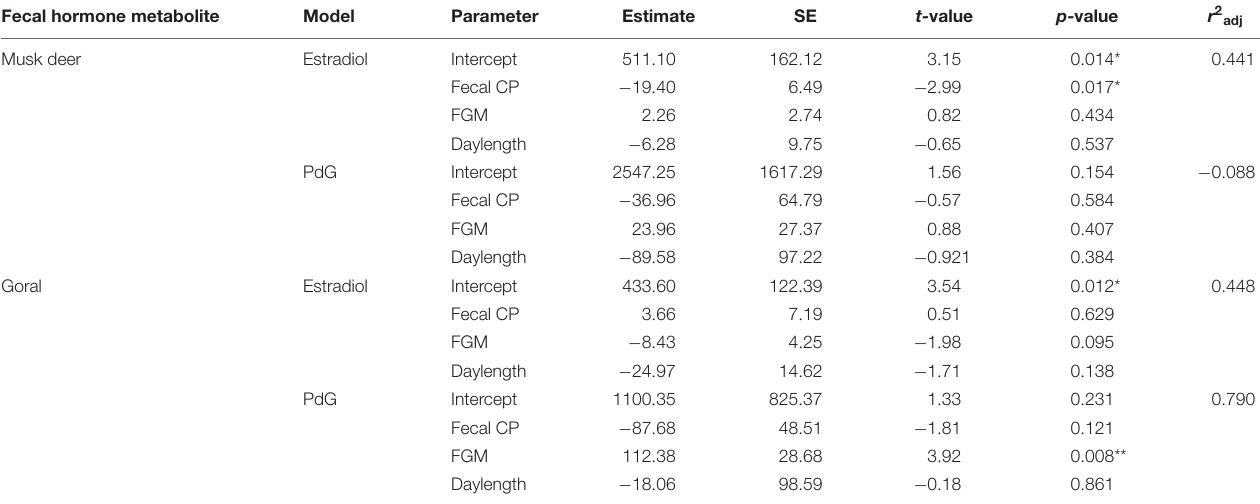
TABLE 3 | Model parameter estimates and adjusted R-squared values ( r 2 adj ) of linear regression models used to fit fecal hormone metabolites (estradiol and PdG) of musk deer and goral against fecal CP, FGM and daylength. Fecal hormone metabolite Model Parameter Estimate SE t- value p -value r 2 adj